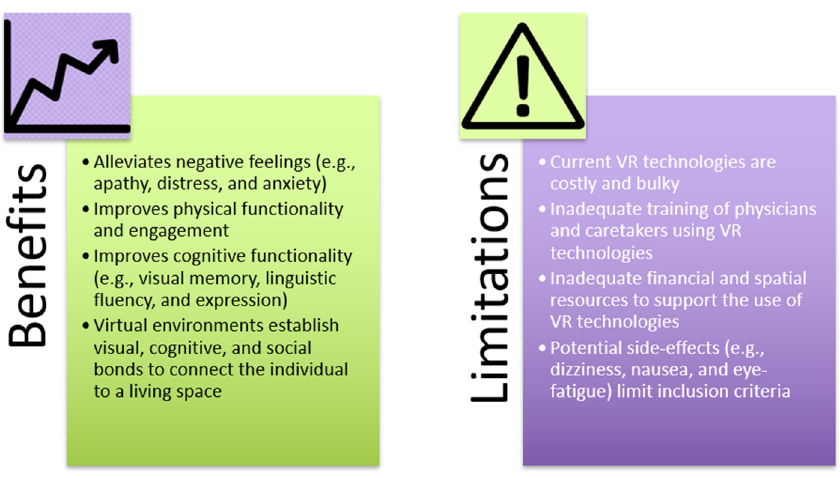
Figure 2. Potential benefits and limitations of the use of VRT in LTCFs.